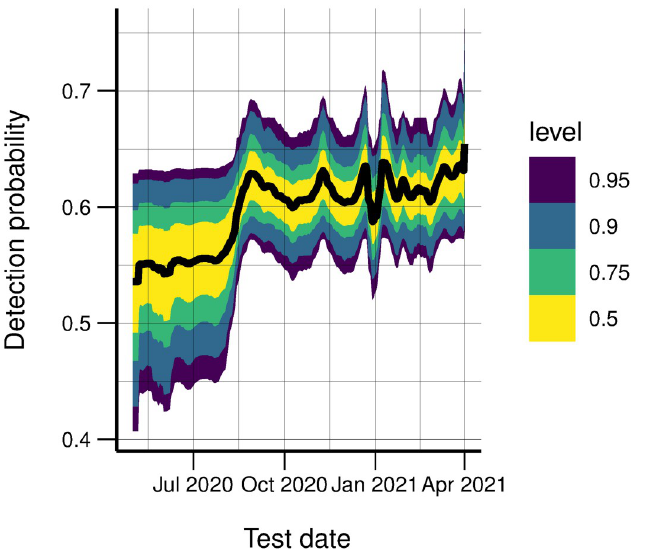
Fig 2. Detection probability. Estimated probability to detect a case by